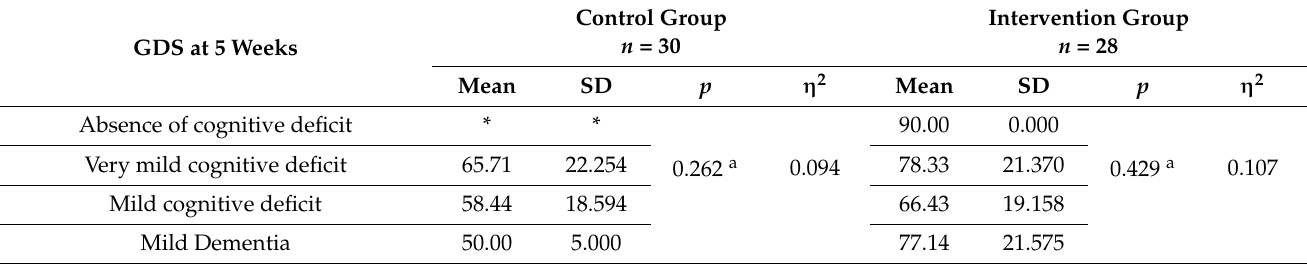
Table 3. Comparison of the Barthel Index scores after the intervention (at 5 weeks) and the severity of the dementia (GDS).